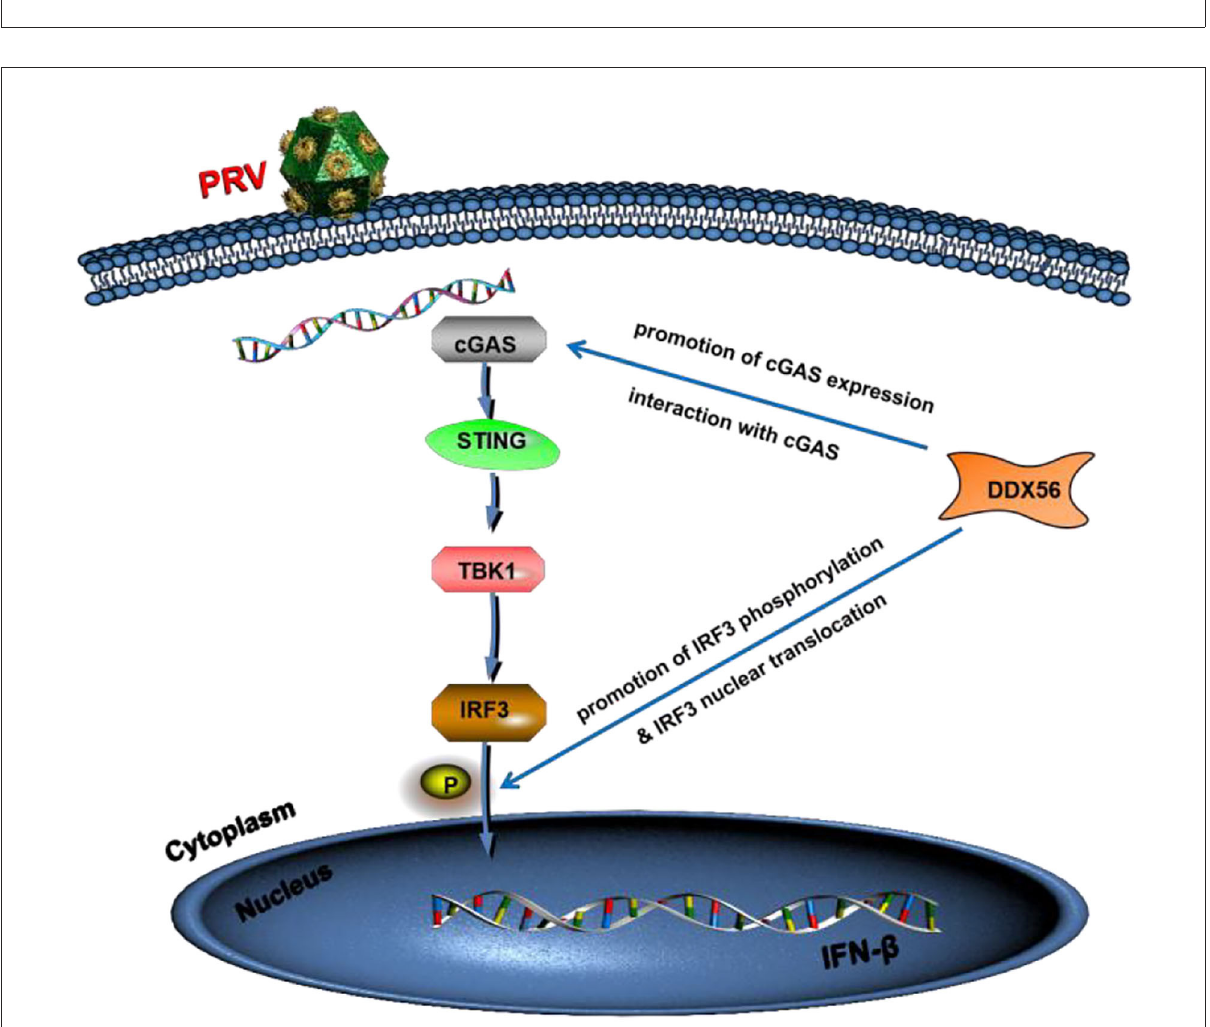
FIGURE9 Model of DDX56 promotes IFN- β pathway activation to inhibit PRV infection. Cellular protein DDX56 promotes cGAS expression and interacts with cGAS. Further study shows DDX56 does not affect IRF3, but it promotes PRV-induced IRF3 phosphorylation. As expected,